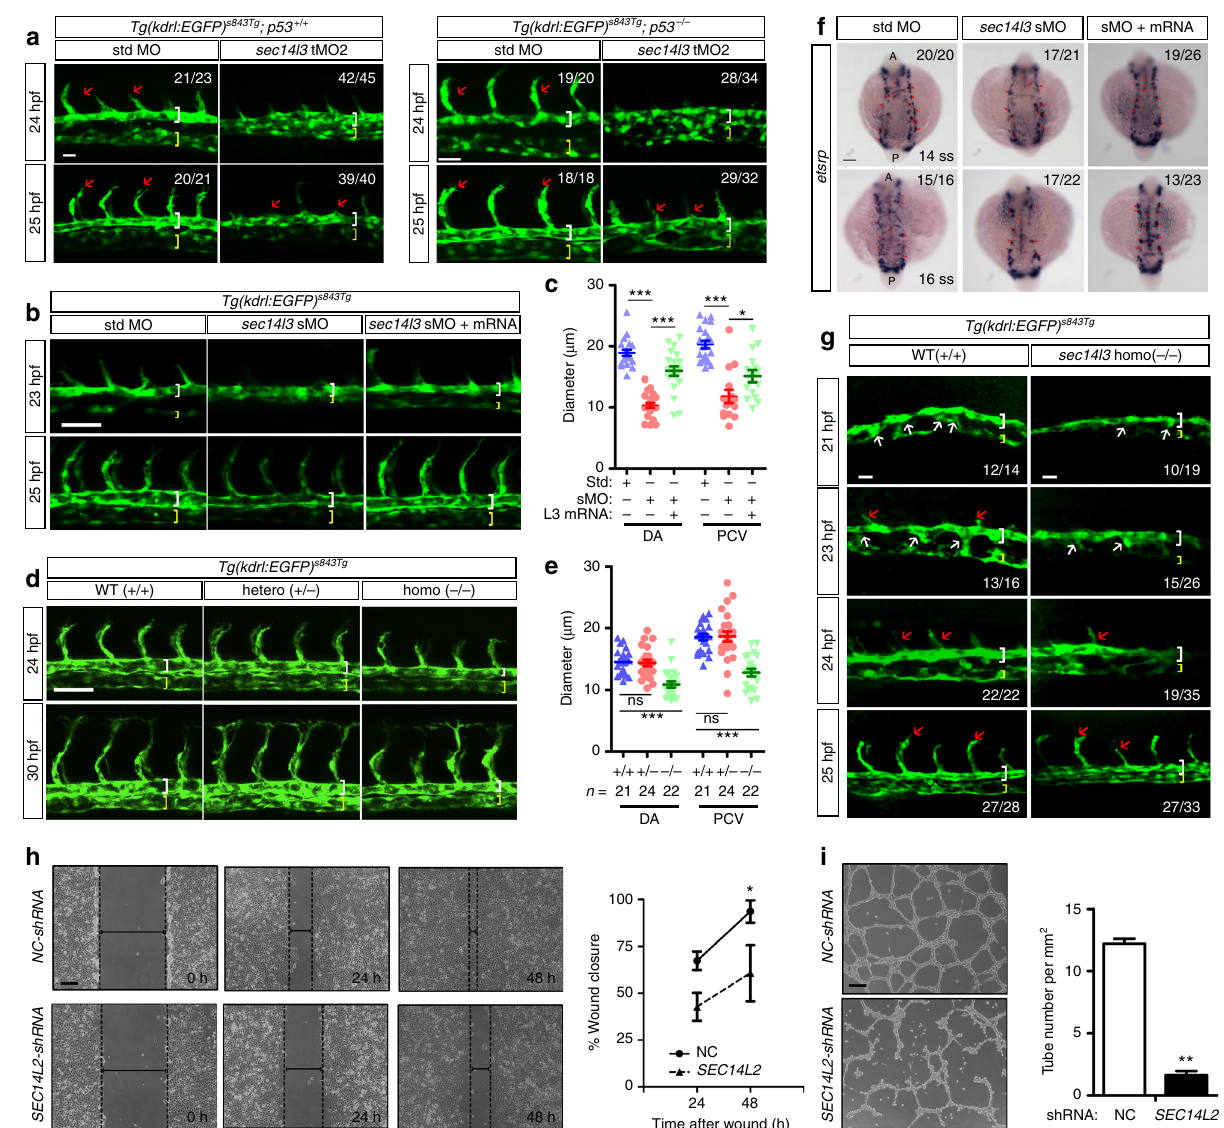
Fig. 2 sec14l3/SEC14L2 are required for vascular formation in vivo and in vitro. a sec14l3-tMO injection impairs arterial-venous segregation and luminal formation in zebra fi sh. Embryos of Tg(kdrl:EGFP) s843Tg ;p53 + / + (left panel) or Tg(kdrl:EGFP) s843Tg ;p53 − / − fi sh (right panel) were used. White and yellow brackets indicate DA and PCV respectively; red arrows indicate ISVs sprouting. The ratio in the right corner indicates the number of embryos with observed pattern/the total number of observed embryos. b sec14l3-sMO mediated knockdown of sec14l3 causes trunk vascular defects. 0.5 ng sec14l3-sMO and 150 pg sec14l3 mRNA were co-injected for rescue experiment. c Statistical analyses of DA and PCV diameters at 25 hpf in b ( n = 20 embryos). d Vasculature defects in sec14l3 mutant embryos. Heterozygous mutants were intercrossed and embryos were harvested for vasculature observation and genotyping analysis individually. e Statistical analyses of DA and PCV diameters at 30 hpf in d . The total number of embryos in each genotype is indicated. f sec14l3-sMO injection causes angioblast migration defects. 0.5 ng sec14l3-sMO and 100 pg sec14l3 mRNA were co-injected for rescue experiment. WISH using etsrp probe marks the medial (arrowhead) and lateral (arrow) progenitor populations simultaneously. g Ventral sprouting defects in sec14l3 mutant embryos. h SEC14L2 knockdown inhibits the in vitro wound closure process. HUVECs infected with control or SEC14L2 shRNA were used for wound closure observation. The ratio of recovered wound width at a speci fi c time point post-wounding to the initial wounding width was calculated. Dashed lines indicate wound edges. Statistical data are shown ( n = 3). i SEC14L2 knockdown inhibits in vitro tube formation. HUVECs were infected with shRNA-packed lentivirus and the complete tube number was scored per fi eld at 24 h after plating. The statistical data are shown on the right ( n = 3 independent experiments, 60 fi elds total). All statistical data are shown as mean ± SEM. One-way ANOVA tests were used for statistical analyses in c , e and t -tests were used for h – i . * p < 0.05; ** p < 0.01; *** p < 0.01; ns, not signi fi cant. Scale bars, 25 μ m for a , 50 μ m for b , d , g , and h – i , 100 μ m for f . Source data are